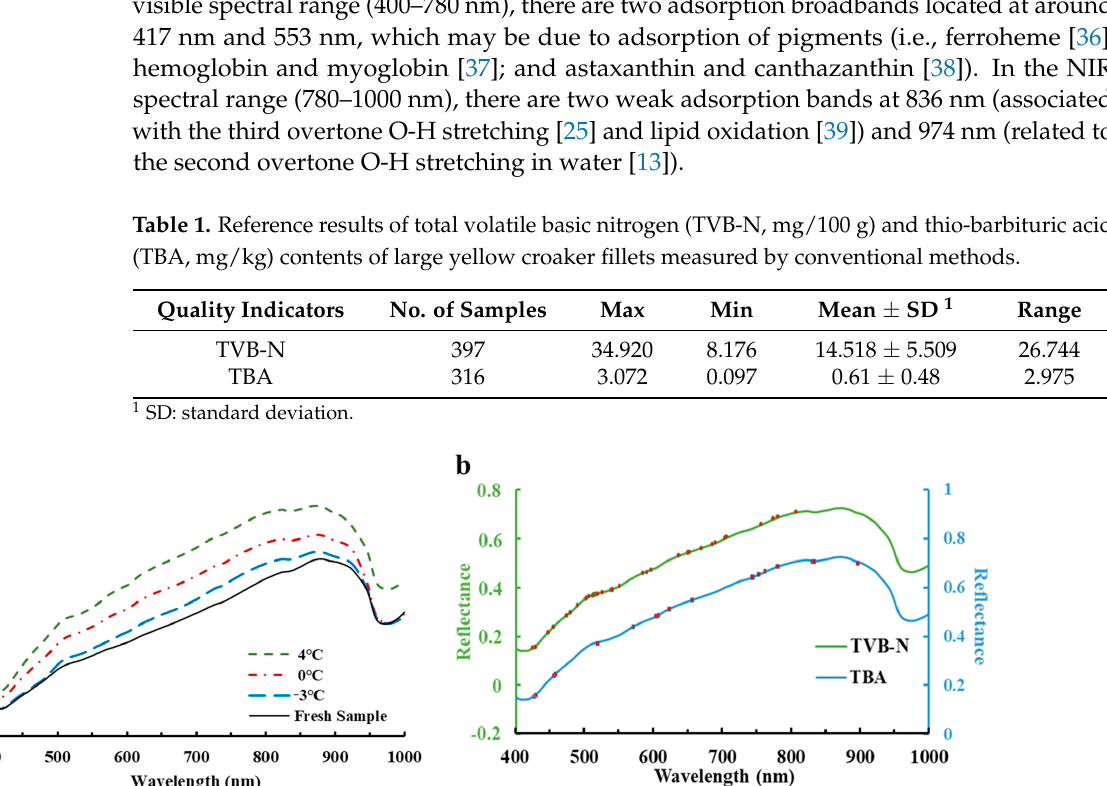
Table 1. Reference results of total volatile basic nitrogen (TVB-N, mg/100 g) and thio-barbituric acid (TBA, mg/kg) contents of large yellow croaker fillets measured by conventional methods.